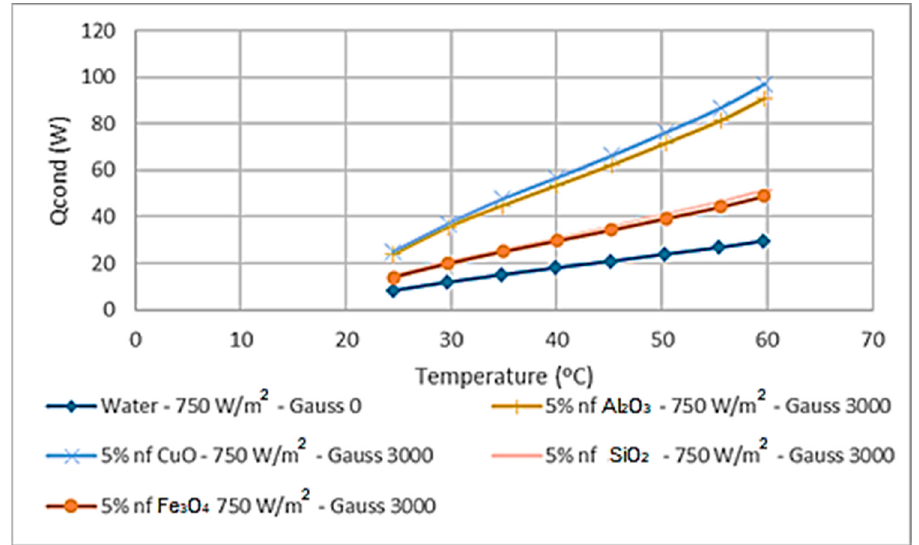
Figure 23. Thermal energy released in heat pipe condenser section.